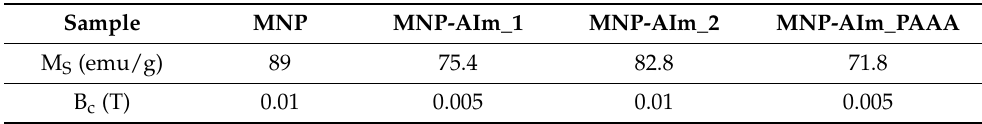
Table 2. The saturation magnetization (M S ) and coercivity (B c ) for the samples MNP, MNP-AIm_1, MNP-AIm_2 and MNP-AIm_PAAA.